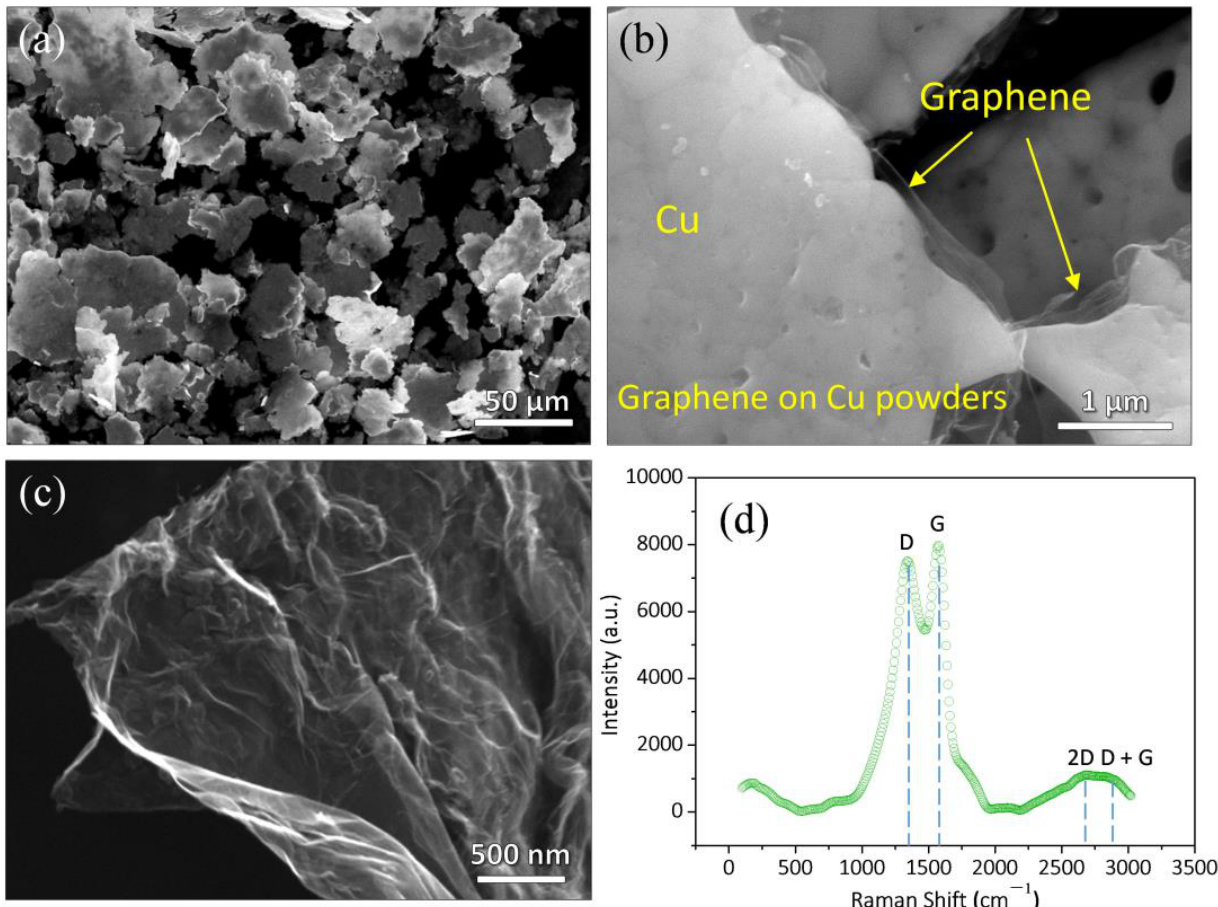
Figure 1. SEM morphology of ( a ) initial flake Cu powders, ( b ) as-grown graphene on Cu powders, and ( c ) graphene after etching Cu, ( d ) Raman curve of as-grown graphene (magnifications for ( a – c ) are ×1000, ×60,000, and ×50,000, respectively).